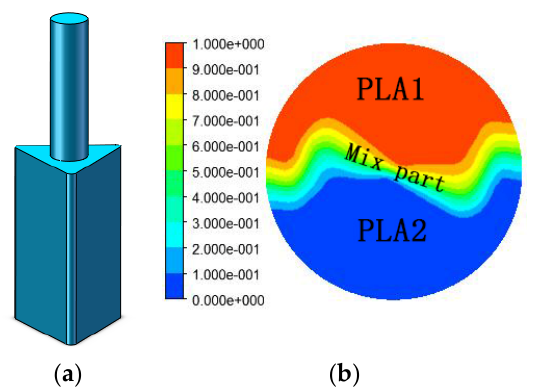
Figure 4. (a) Triangular stirring shafts applied in simulation and (b) exit section phase distribu- Figure 4. ( a ) Triangular stirring shafts applied in simulation and ( b ) exit section phase tion .